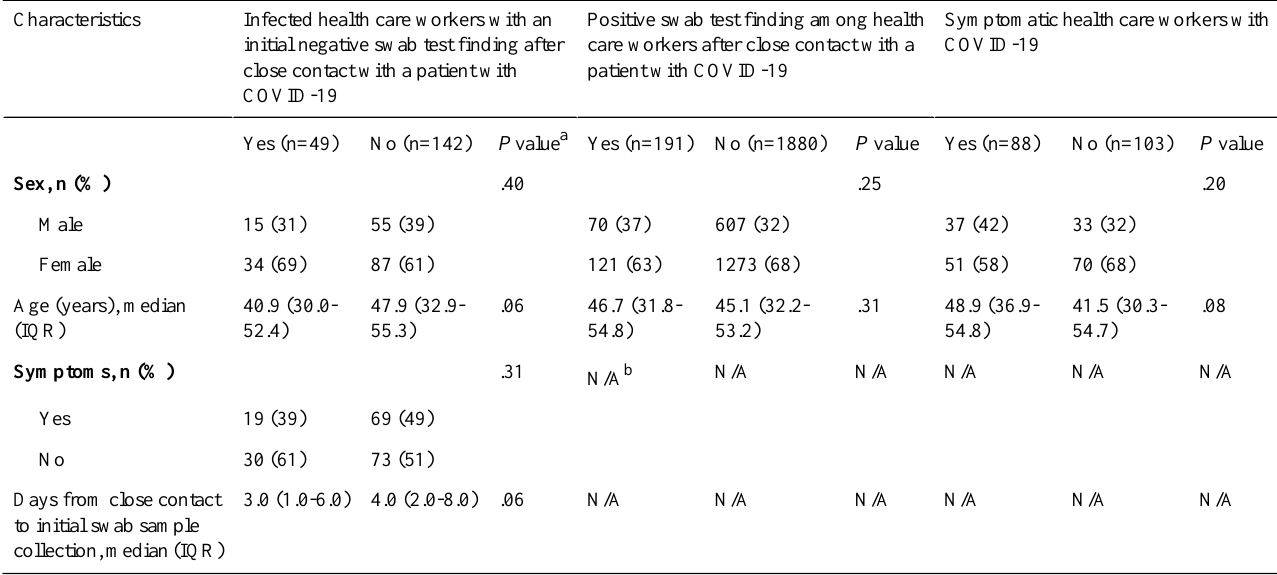
Table 1. Characteristics of health care workers at University Hospital of Verona (Italy) distinguished by SARS-CoV-2 swab test results and the presence of symptoms (data collected between February 29 and April 17,